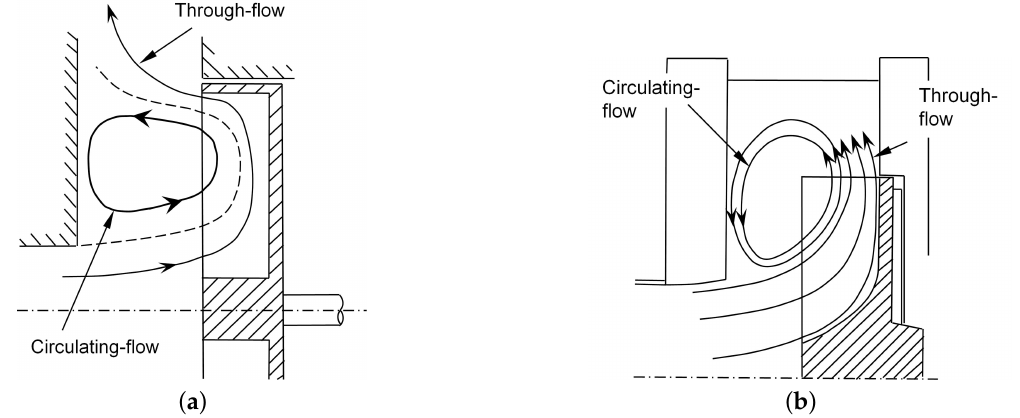
Figure 7. ( a ) Flow model for the covered design (adapted from [31]); and ( b ) flow model for the open design (adapted form